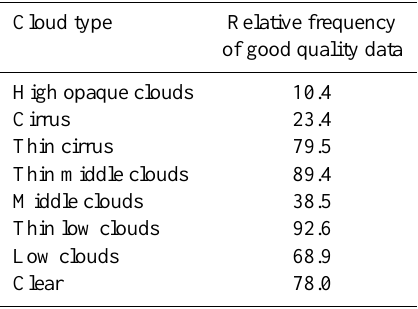
Table 2. Frequency for which atmospheric profiles are of good quality within each AIRS cloud type. All regions and all seasons combined.